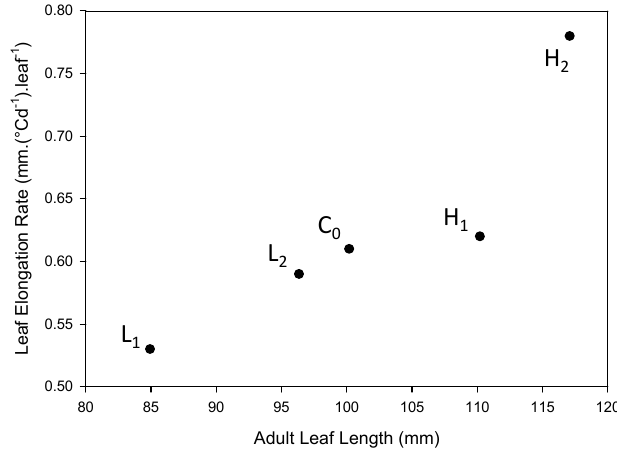
Figure 3. Response of leaf elongation rate and adult leaf length to divergent selection for lamina length on spaced plants (adapted from [15]). Means of long-leaved (H) and short-leaved (L) populations after 1 or 2 years of selection and mean of the initial (C 0 ) population. Examples of a turf and a forage variety are also